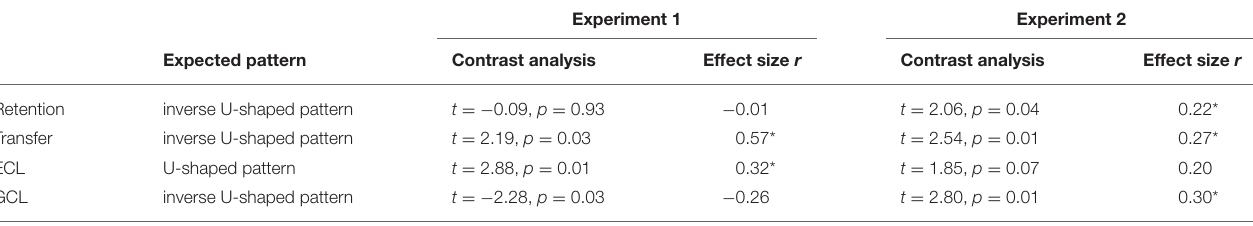
TABLE 3 | Comparison of the results between both